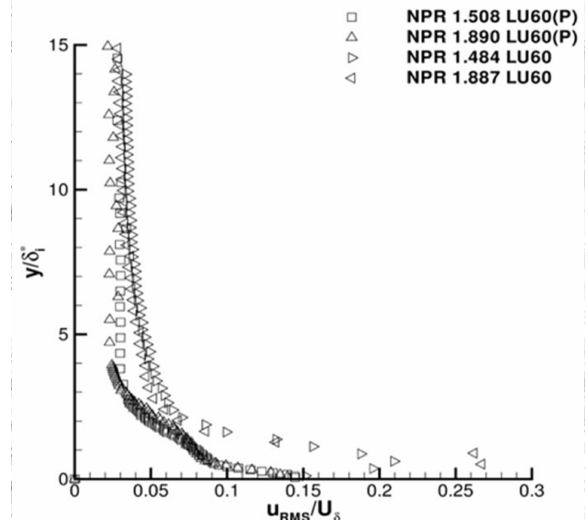
Figure 16. LU60/LU60P nozzle exit u rms